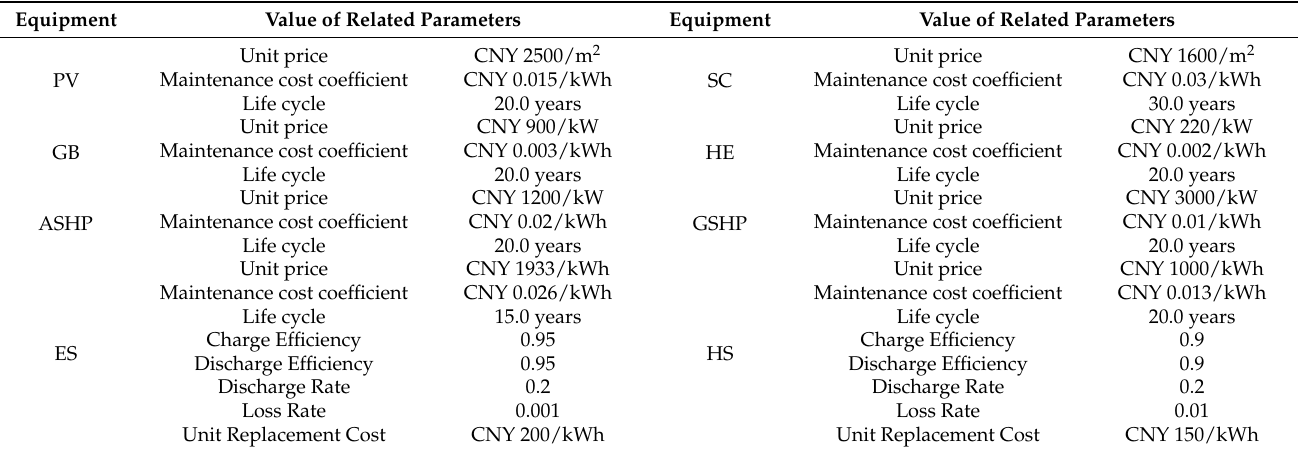
Table 2. List of equipment-related